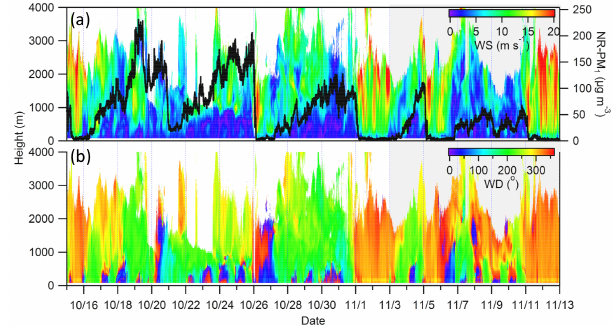
Figure 1. Evolution of vertical profiles of (a) wind speed (WS) and (b) wind direction (WD) from the measurements of the Doppler wind lidar. The time series of NR-PM 1 (i.e., Org + SO 2 − + Cl − ) is shown as the black line in (a) . The shaded area NH + 4 refers to the APEC period (same for following